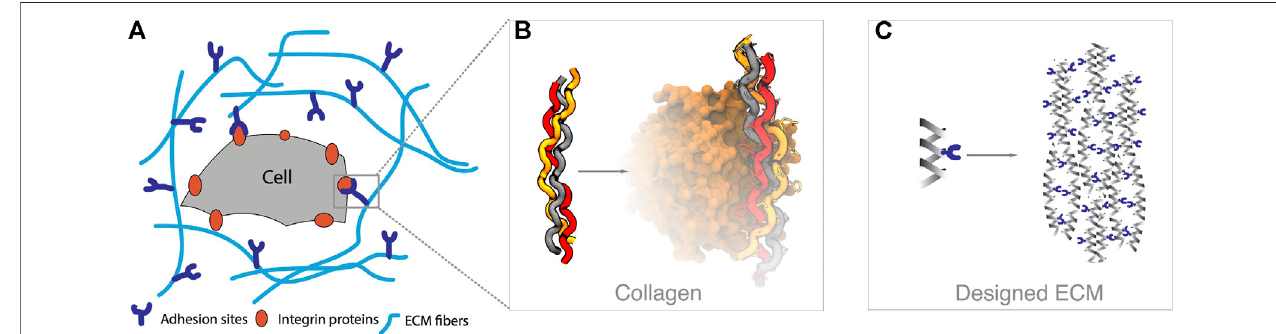
FIGURE 10 | Tissue engineering overview. (A) The surface of a cell is covered with different types of integrin proteins, which recognize molecular queues in the extracellular matrix (ECM) environment. (B) The ECM is composed of diverse biological components, such as collagen fi bers, which can interact with integrins through speci fi caminoacidsequences(e.g.,GFOGERintheexample,pdbid1dzi). (C) Thegoalintissueengineeringistodesignmaterials,suchasself-assemblingpeptidesthat provide an ECM scaffold and chemical queues that can trigger cellular